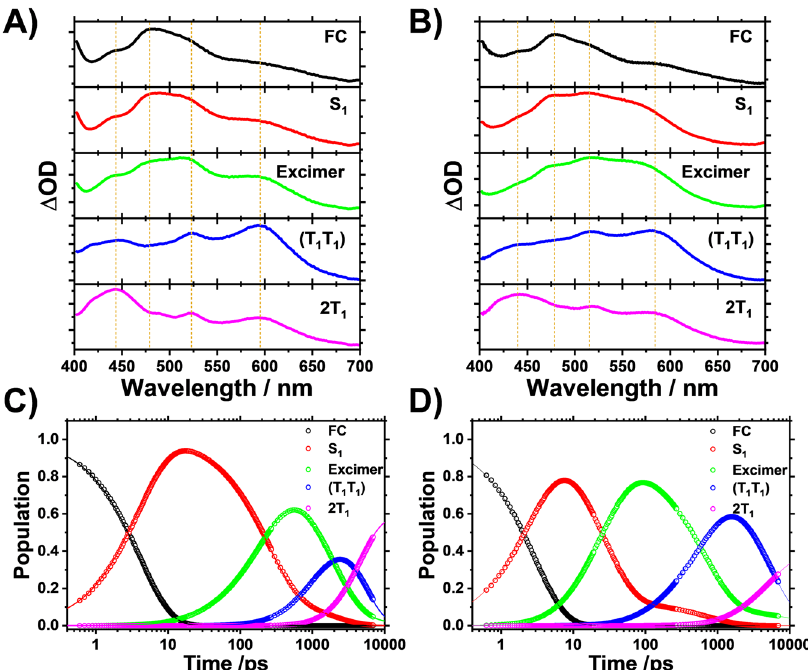
Fig. 5 Species-associated difference spectra and population changes of intermediates for Anti -DPyB obtained from the kinetic analysis for Kinetic Model (2) in n -hexane and acetonitrile. A , B Species-associated difference spectra in A n -hexane and B acetonitrile. C , D Population changes of intermediates in C n -hexane and D acetonitrile. The solid lines are the concentrations obtained from the kinetics analysis. The open circles represent the measure time